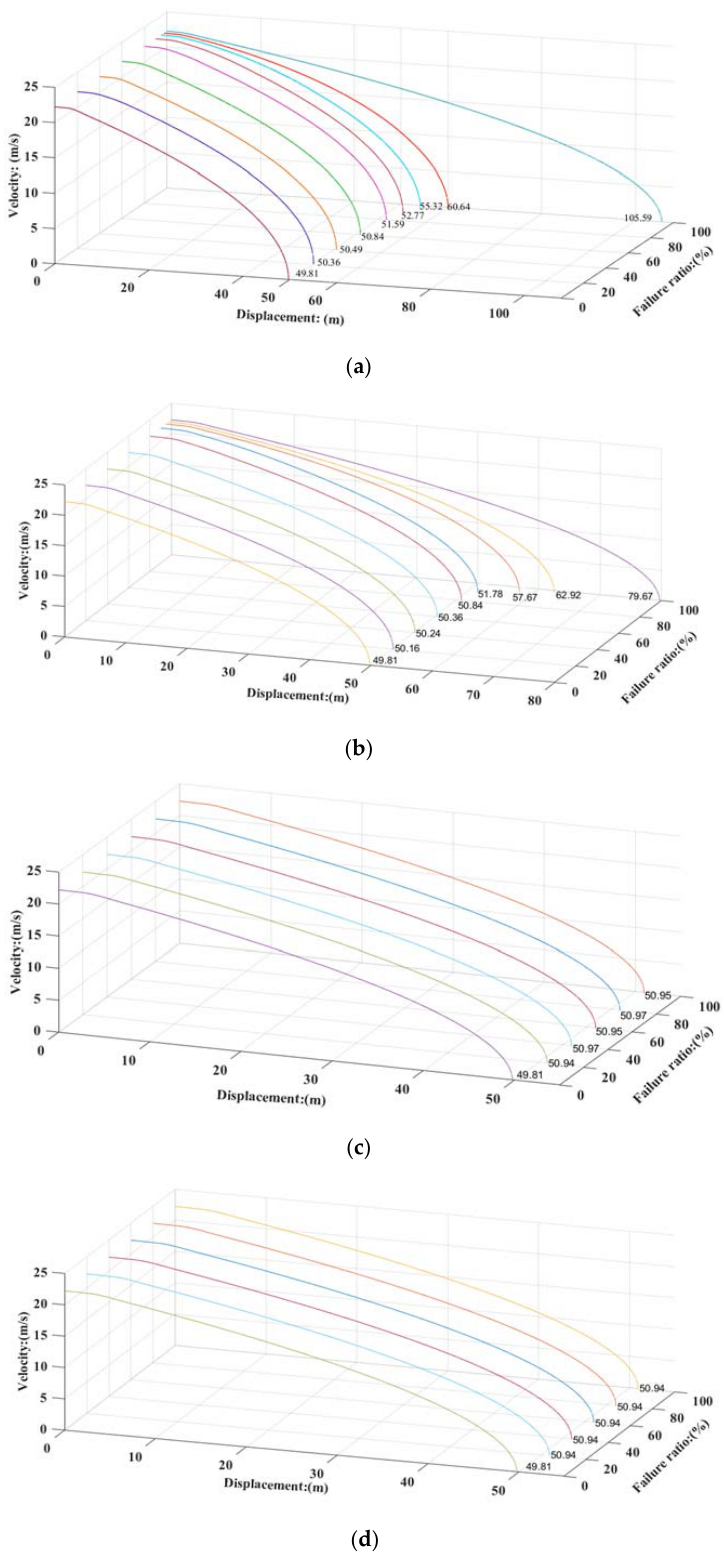
Figure 23. Velocity-displacement curves of di ff erent failure ratios. ( a ) mode 1 ; ( b ) mode 2 ; ( c ) mode 3 ; Figure 23. Velocity ‐ displacement curves of different failure ratios. ( a ) mode 1 ; ( b ) mode 2 ; ( c ) mode 3 ; ( d ) mode 4 ( d ) mode 4 .